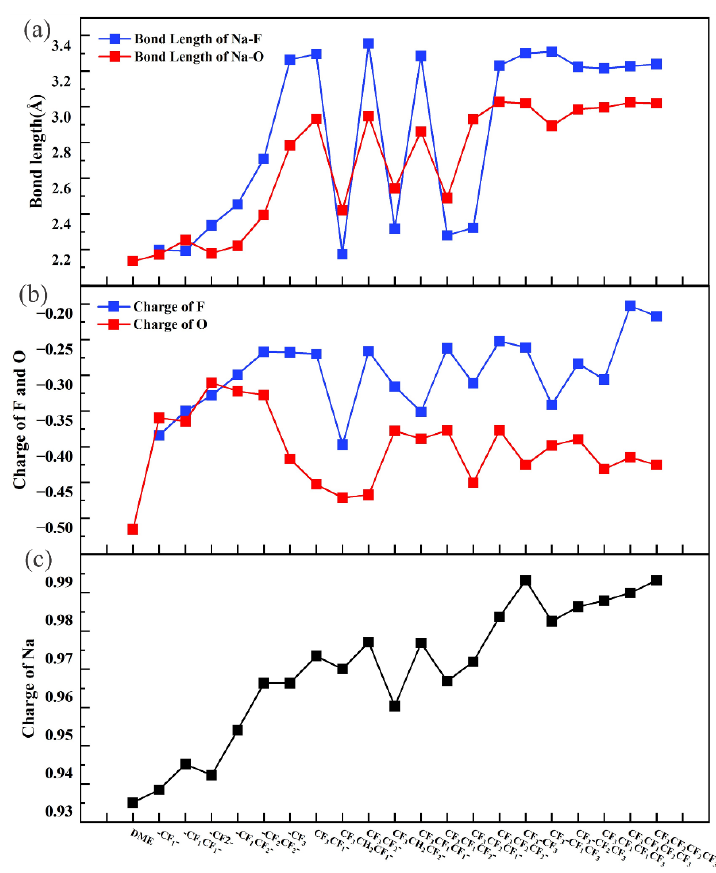
Figure 3. Bond length of B Na-O and B Na-F ( a ). Atom charge of O, F ( b ) and Na-ion ( c ). The variation of bond lengths is highly correlated with types, numbers, and relative positions of those units and also with the number of F atoms, showing “unidirectional variational”, “oscillating”, and “convergent” tendencies, which could also be reflected to some extent in subsequent studies.